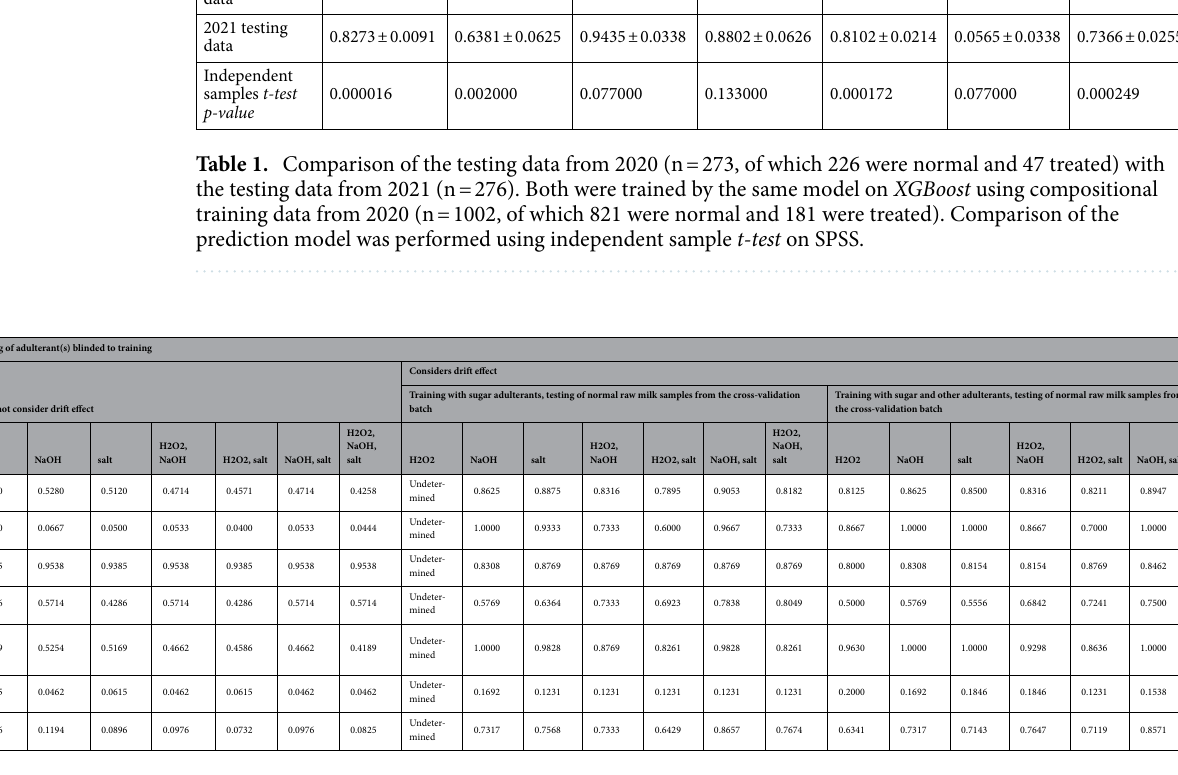
Table 2. Cross-validation with the blind-tested samples and the respective accuracy, sensitivity, specificity, precision, negative predictive value, false alarm, and F1 score. Comparison of drift effect by excluding and including sugar (glucose, fructose, and sucrose) adulterants from the same batch of blind-tested samples in the training dataset. A comparison analysis by including and excluding other adulterants not excluded from the training dataset was also performed. Hydrogen peroxide (H 2 O 2 ), sodium hydroxide